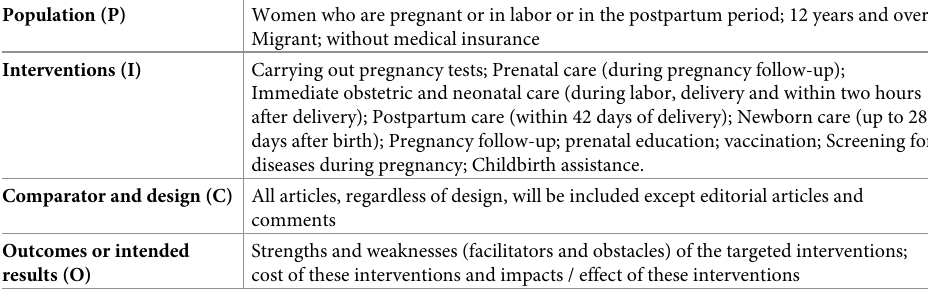
Table 1. PICO (Population, Interventions, Comparator and design, Outcomes). Population (P) Women who are pregnant or in labor or in the postpartum period; 12 years and over; Migrant; without medical insurance Interventions (I) Carrying out pregnancy tests; Prenatal care (during pregnancy follow-up); Immediate obstetric and neonatal care (during labor, delivery and within two hours after delivery); Postpartum care (within 42 days of delivery); Newborn care (up to 28 days after birth); Pregnancy follow-up; prenatal education; vaccination; Screening for diseases during pregnancy; Childbirth